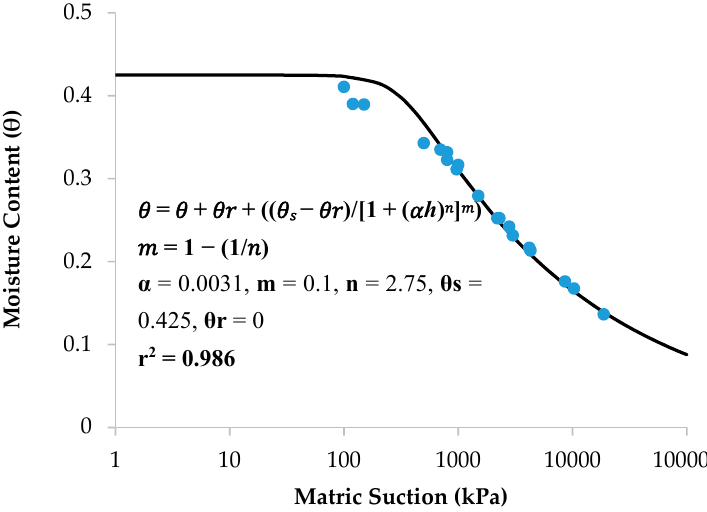
Figure 3. Soil water retention curve of Yazoo clay